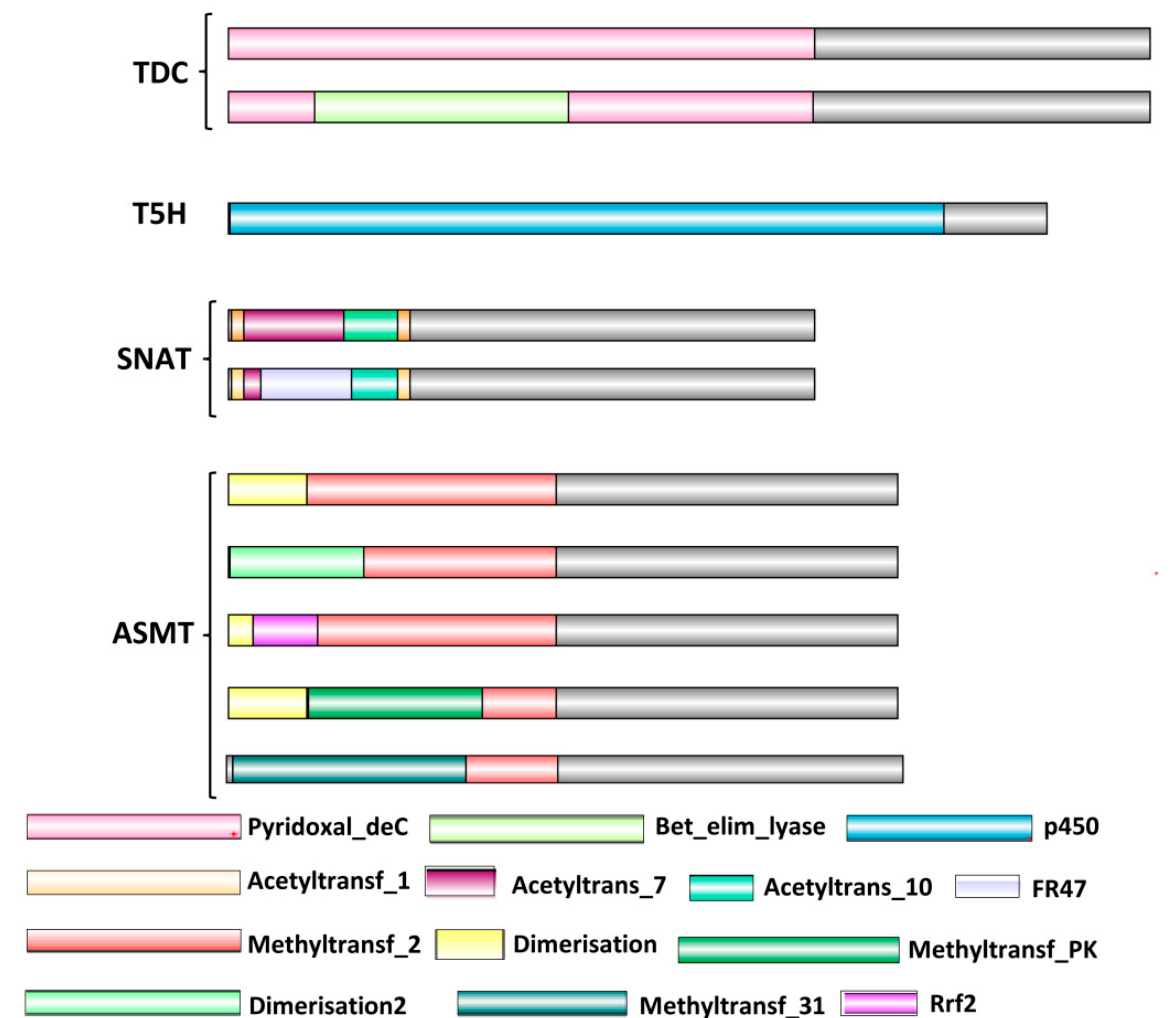
Figure 2. Schematic representation of domain architecture of Ser and Mel biosynthetic enzymes. Domains were analysed using the Pfam database. Lengths of domains shown are not to the scale. TDC , Tryptophan decarboxylase; T5H , Tryptamine-5-hydroxylase; SNAT , Serotonin-N-Acetyl transferase; ASMT , Acetylserotonin methyltransferase.